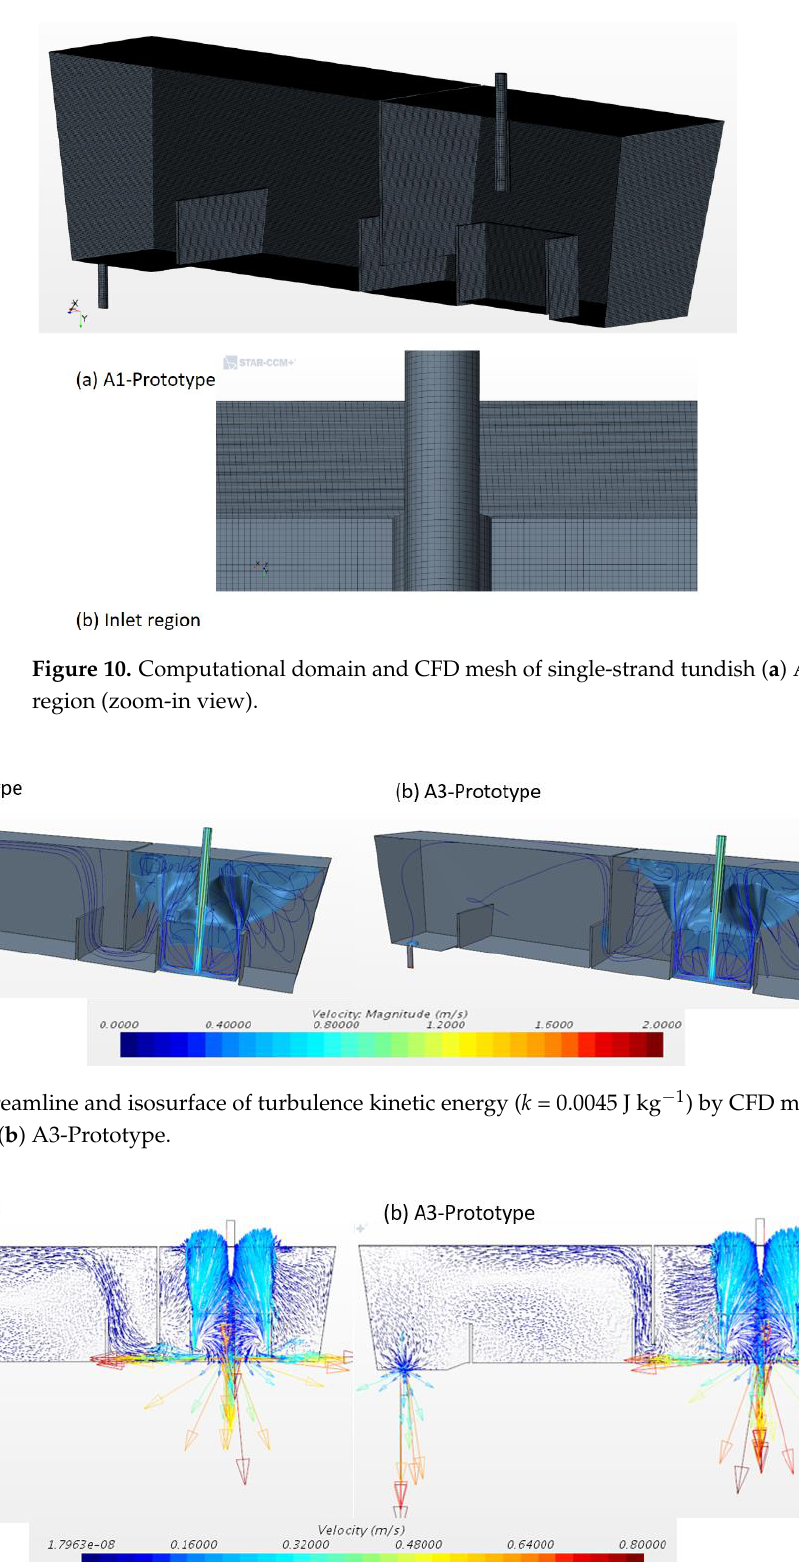
16 of 22 Figure 9. Calculated RTD curves using tanks-in-series model ( a ) Group 1—variation of distance between weir and inlet ( b ) Group 2—variation of depth of weir. 3.3. CFD Model The purpose of the CFD modelling was to confirm the conclusion drawn from water model experiments and theoretical analysis. Two selected CFD simulation cases, A1-pro- totype and A3-prototype, were created for the simulation of the full-scale tundish. The selection of cases is based on the observation of experimental data and theoretical analysis